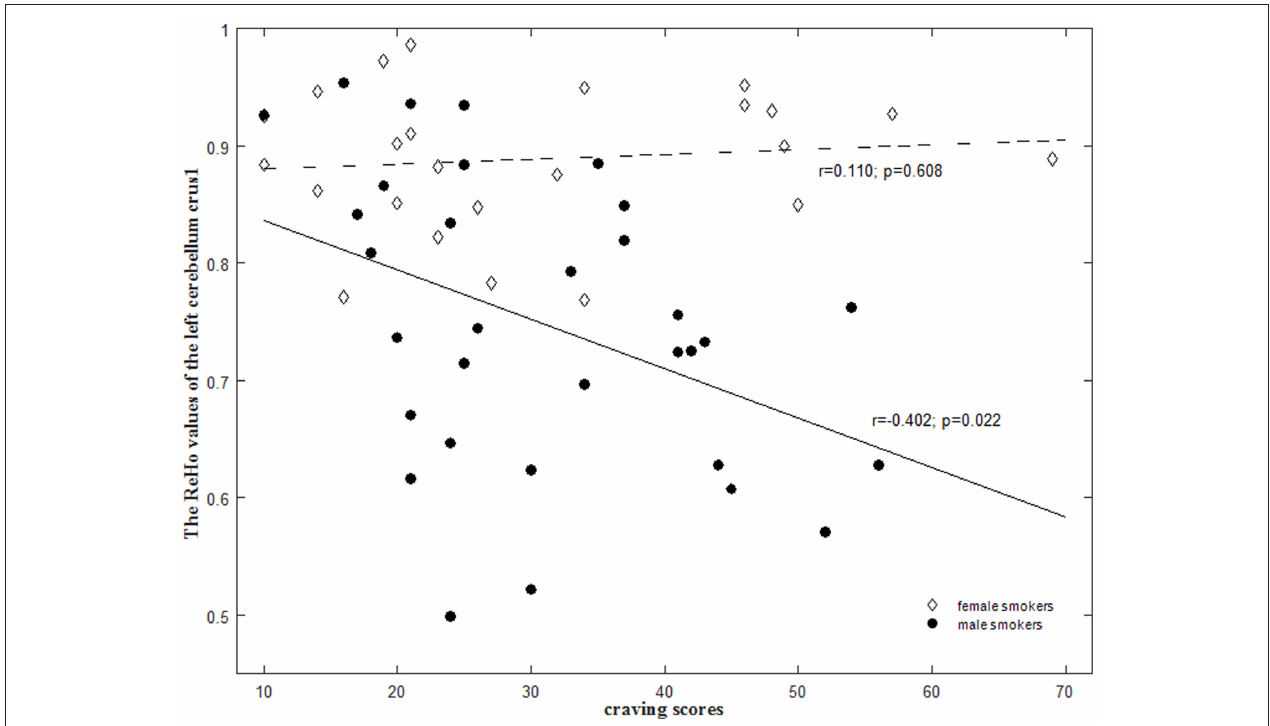
FIGURE 3 | Sex-specific correlations between the regional homogeneity (ReHo) values and smoking-related measures in smokers. There were significant negative correlation of the mean ReHo values in the left cerebellum crus1 with the craving scores in male smokers ( r = − 0.402; p = 0.022) but not in female smokers ( r = 0.110; p = 0.608). These correlations between ReHo values and craving scores were significantly different between male and female smokers ( p =